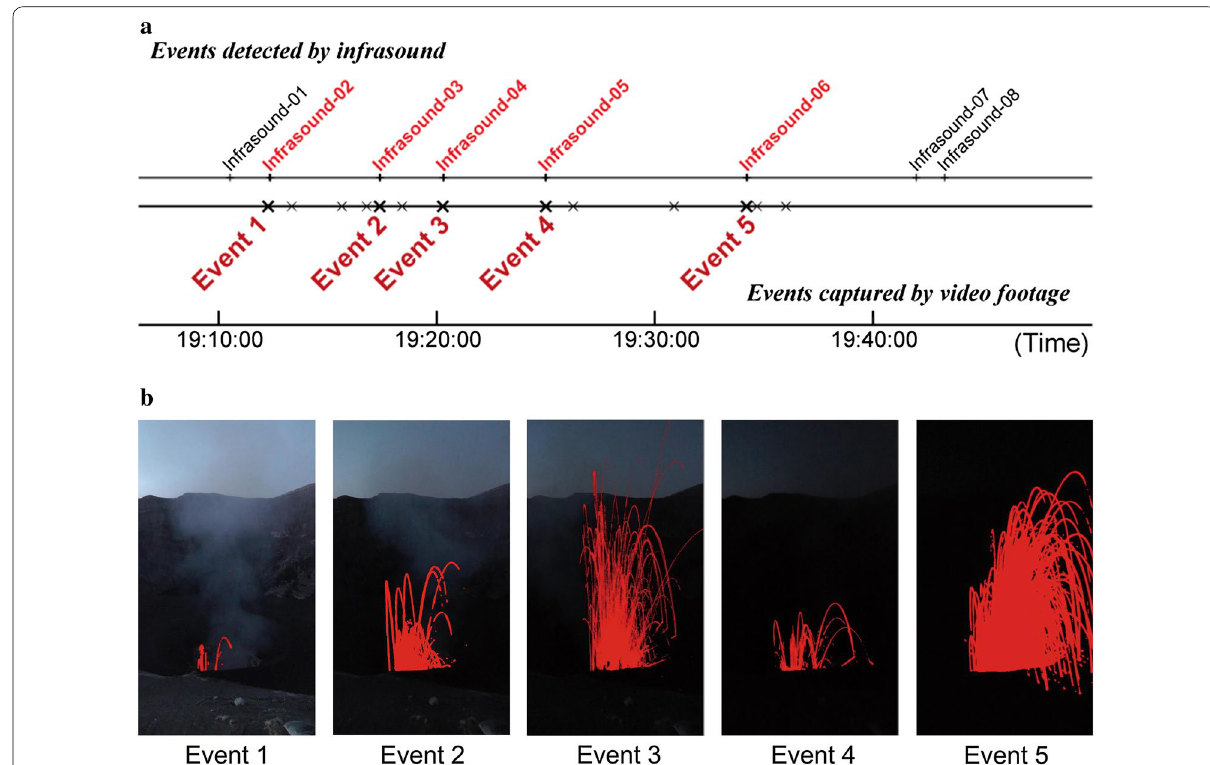
Fig. 2 a Time sequence and events detected via infrasound and video footage. The upper line shows the events detected by infrasound, and the lower line shows events detected by the camera. Red characters show the events detected by both infrasound and video footage. b Synchronized frame images during each bursting